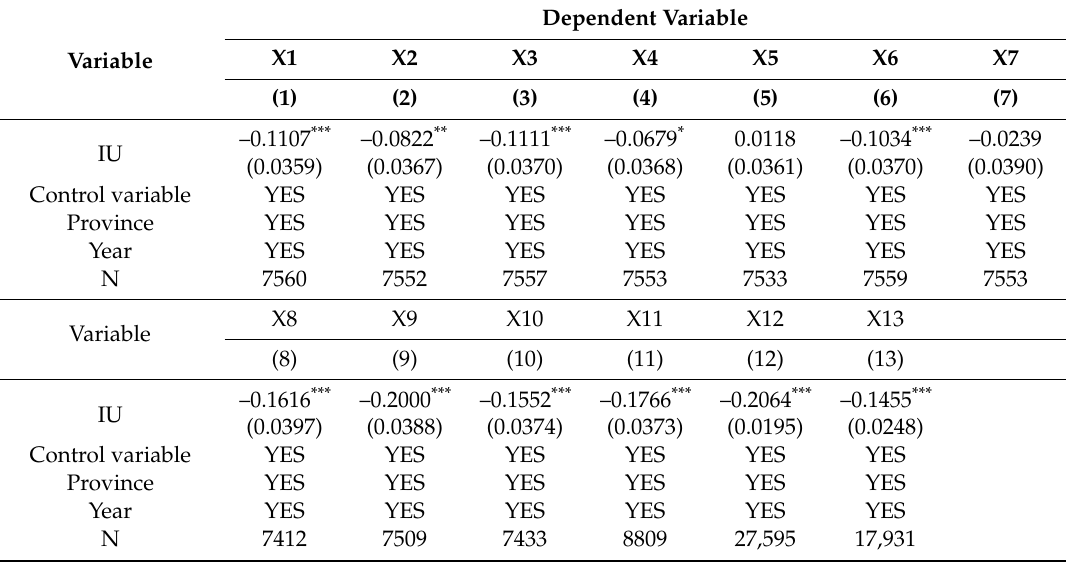
Table 5. The e ff ect of Internet use people’s di ff erent aspects of medical service evaluation.